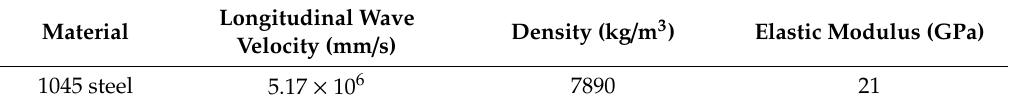
Table 2. Parameters of 1045